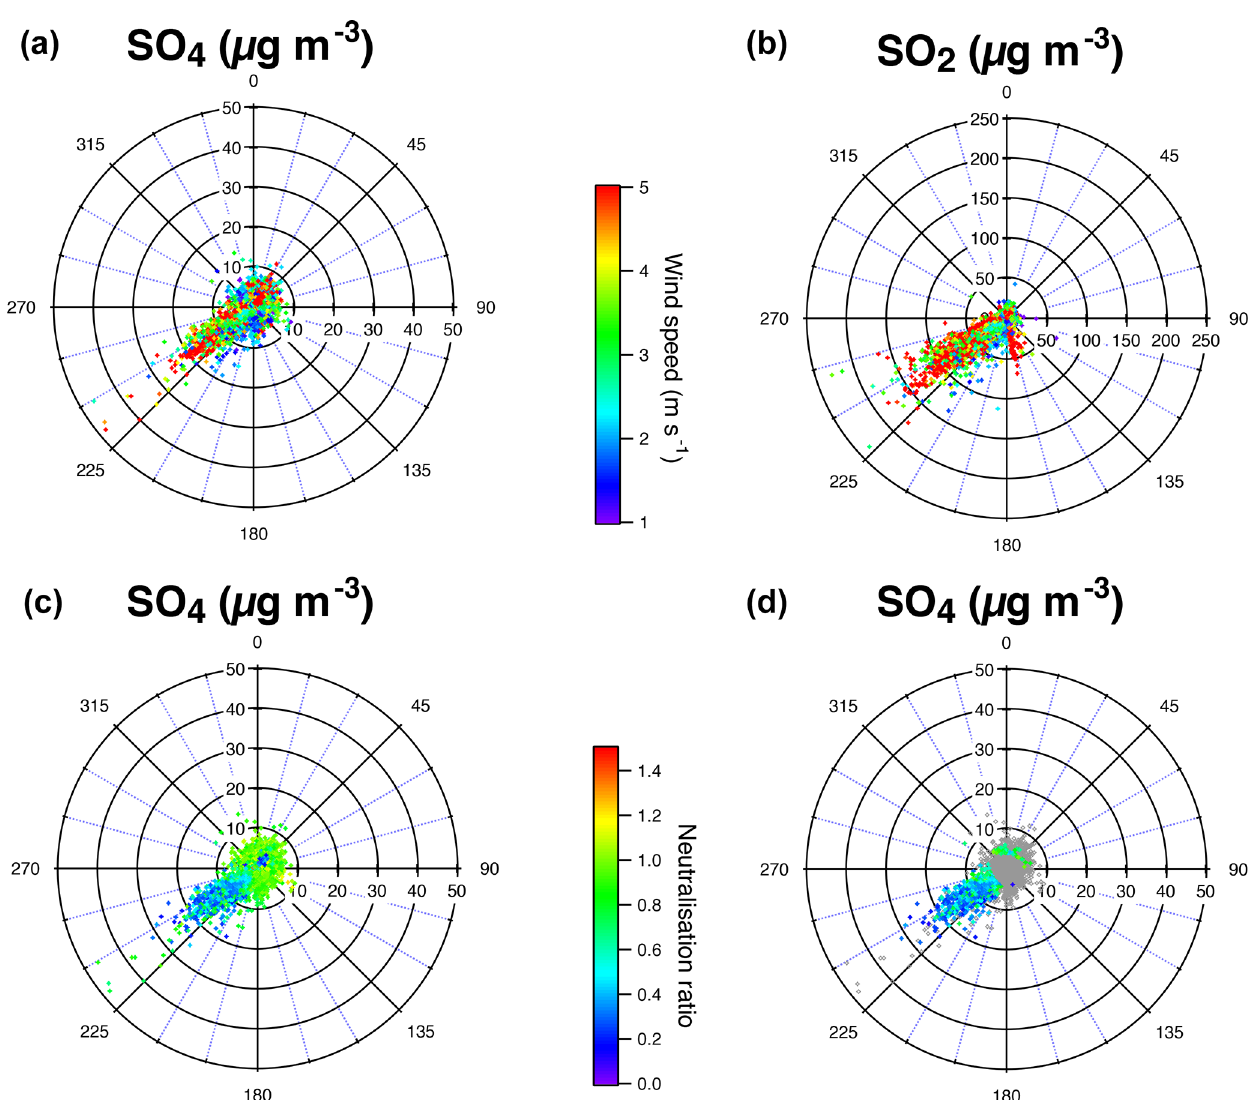
Figure A3. (a, b) Polar plots of (a) sulfate and (b) sulfur dioxide mass concentrations measured at Dunkirk coloured by wind speed from Zhang (2016); (c, d) polar plots of sulfate coloured by the neutralization ratio for (c) the entire dataset and (d) points with NO 3 < 1 and SO 4 > 4µgm − 3